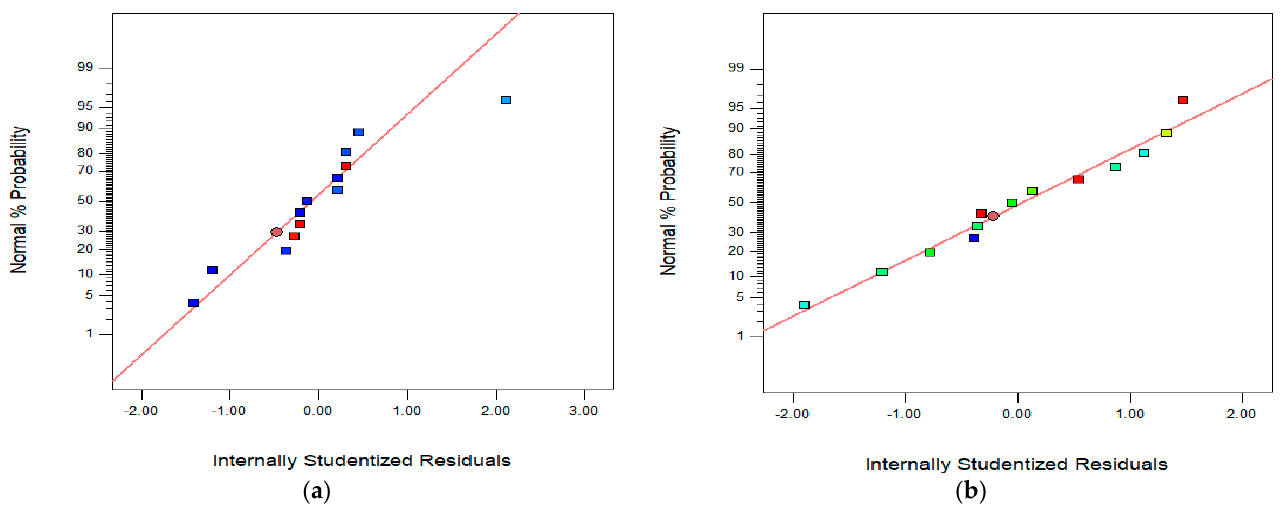
Figure 7. Normal plot against internally studentized residuals for weight reduction models for ( a ) 200 °C model and ( b ) 400 °C model